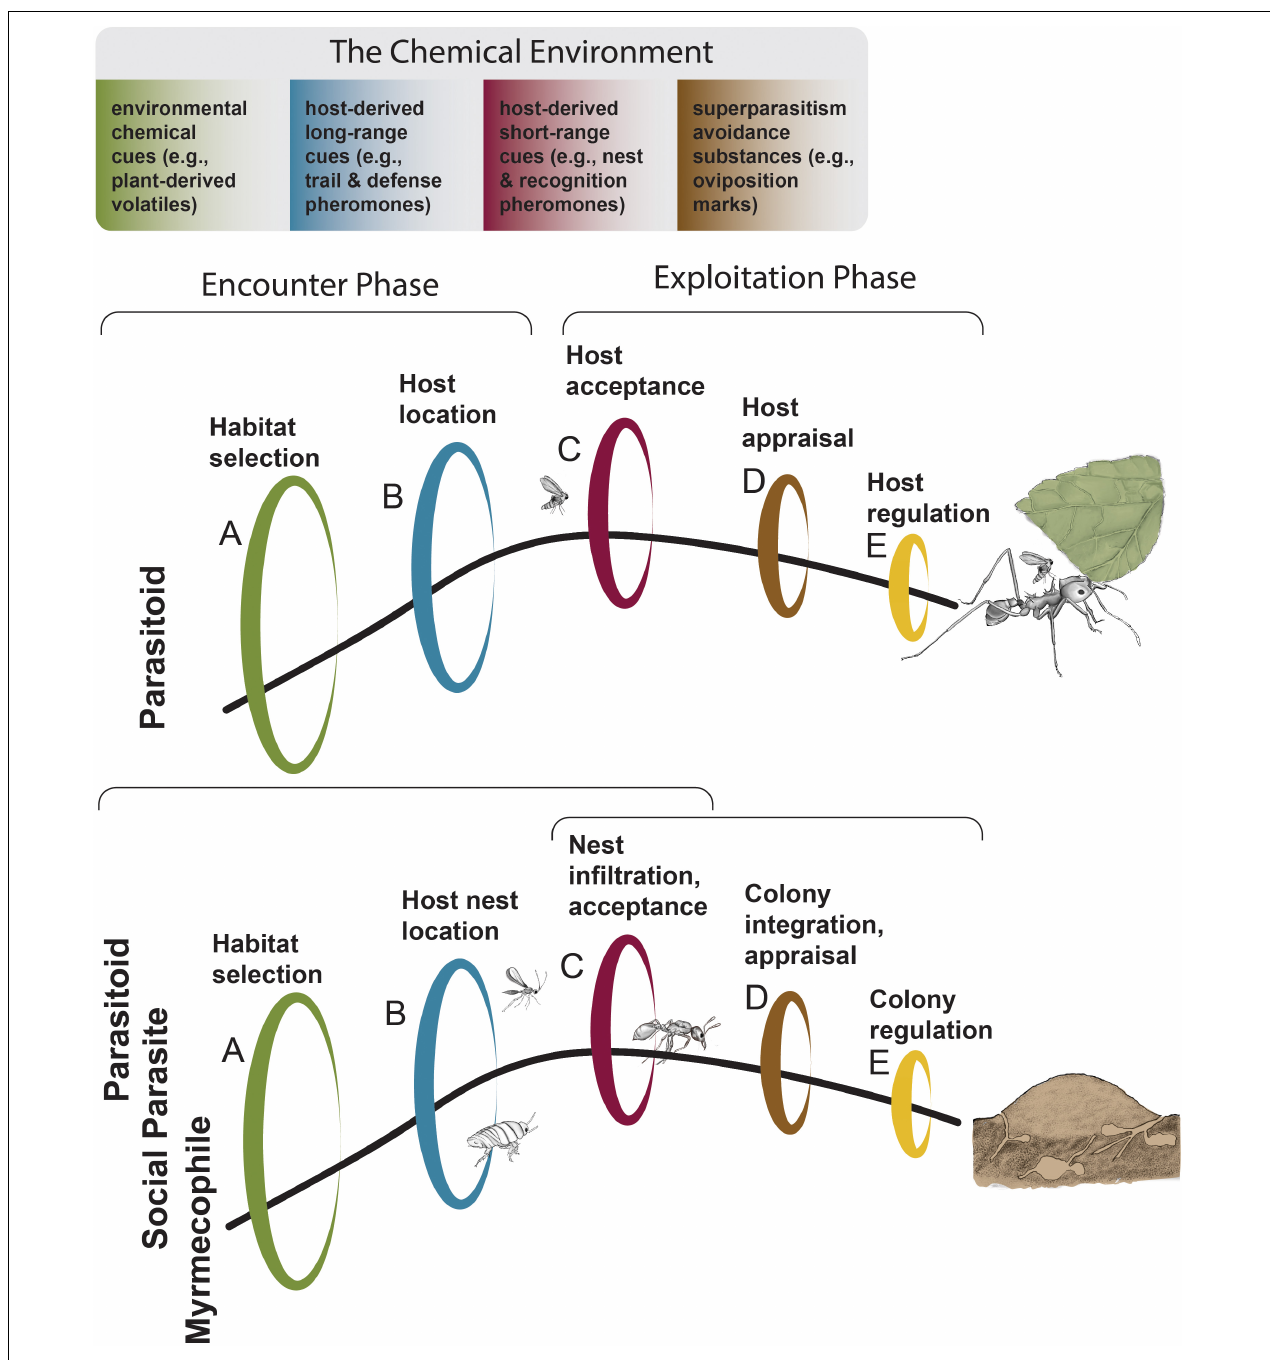
FIGURE 1 | A graphic model of the sequential challenges associates face to successfully exploit an ant host. Different chemical cues can aid the associate in finding and appraising their host. When an enemy is intercepting a signal (e.g., pheromone), this is considered eavesdropping. (A) Habitat selection . Environmental chemical cues can aid the associate in narrowing search patterns. (B) Host location . Host-derived long-range chemical cues can guide the ant associate to a host individual (top panel) or nest (bottom panel) after arriving to the host habitat. (C) Host acceptance . Once the host individual (top panel) or nest (bottom panel) is located, the associate will determine if it is acceptable (e.g., correct species, life stage, caste, etc.). In some cases the associate will infiltrate the nest at this stage (bottom panel). Predators will consume their prey at this stage. (D) Host appraisal . In order to avoid superparasitism, some associate species are able to detect the chemical signature or oviposition-marking of hetero- or conspecifics, thus avoiding the fitness cost of sharing a host. In some cases this can occur at the same time as colony integration within the nest (bottom panel). (E) Host regulation . After infecting the host, the parasite can manipulate host behavior or physiology in order to maximize its fitness gains. Sequential challenges were inspired by Vinson (1976) and Mathis and Philpott (2012) whereas the host encounter phase and exploitation phases were inspired by Combes (2005). Illustrations by Rozlyn E. Haley adapted from photographs by Alex Wild.